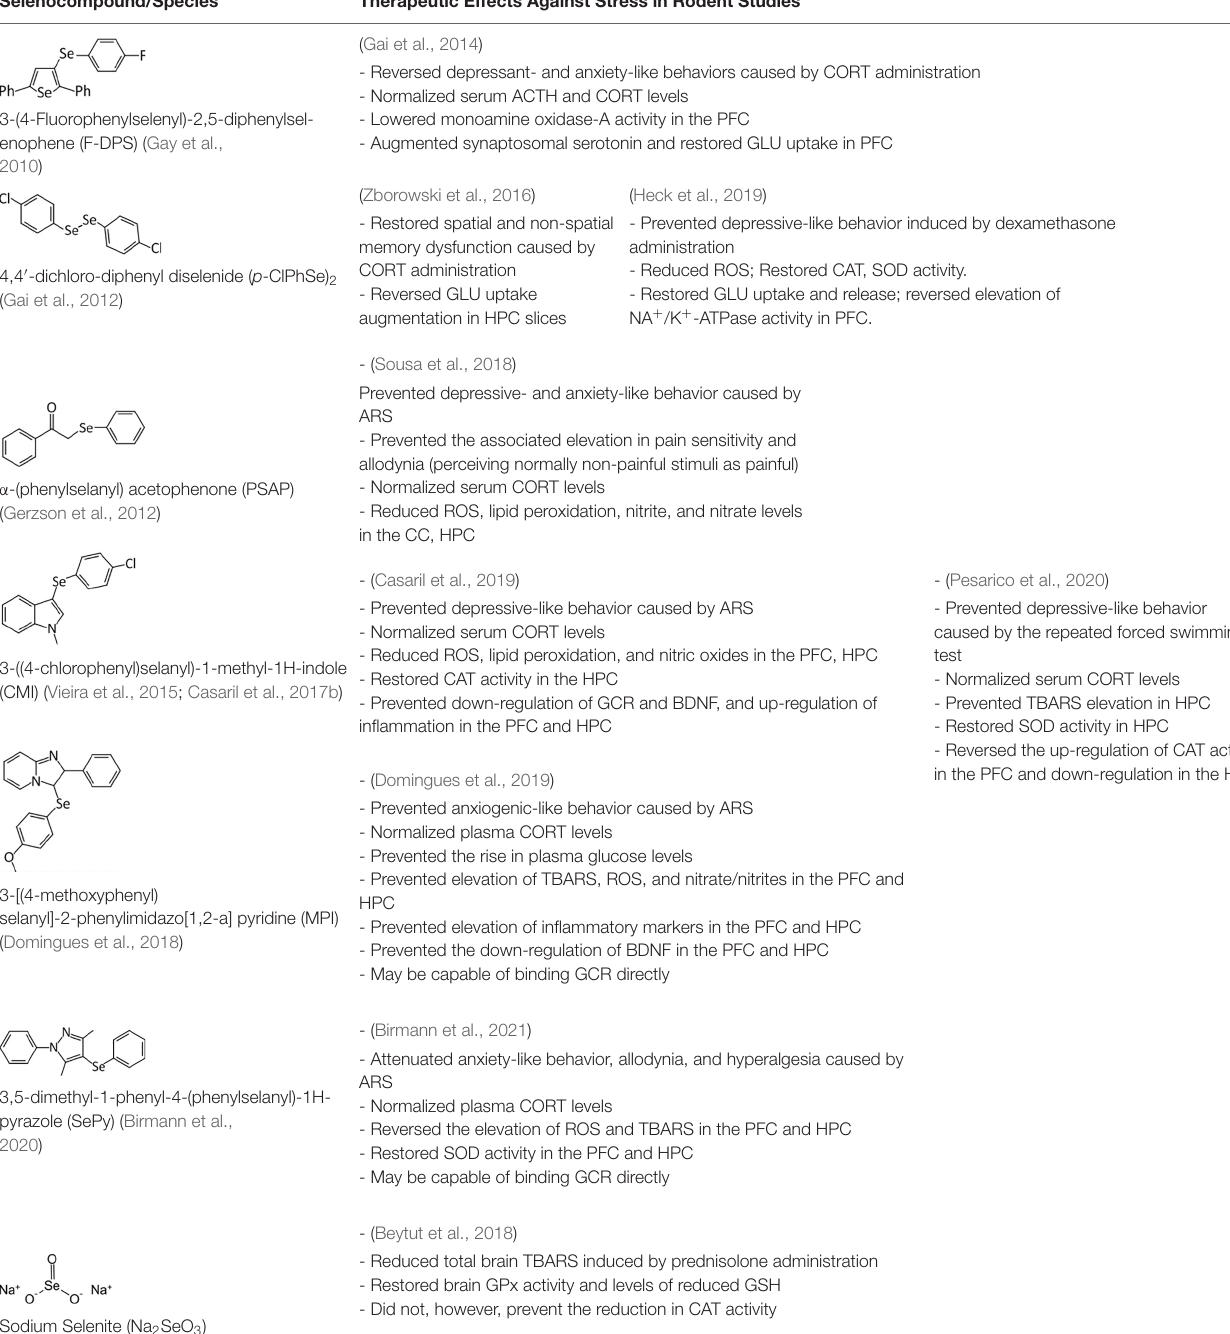
TABLE 1 | Summary of the effects of selenium-containing compounds used in rodent models of stress. Selenocompound/Species Therapeutic Effects Against Stress in Rodent Studies